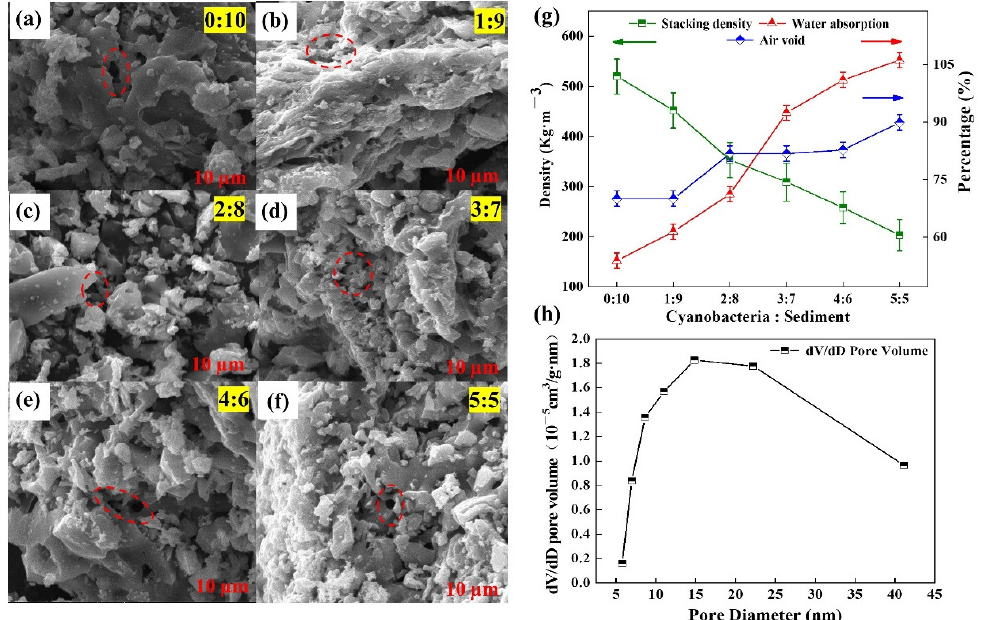
Figure 2. Effect of different cyanobacteria-to-sediment ratios on properties of ceramsite. ( a – f ) are electron microscope structure diagrams of water storage materials under different cyanobacteria-to-sediment ratios, ( g ) is stacking density and air void, and ( h ) is pore size distribution.